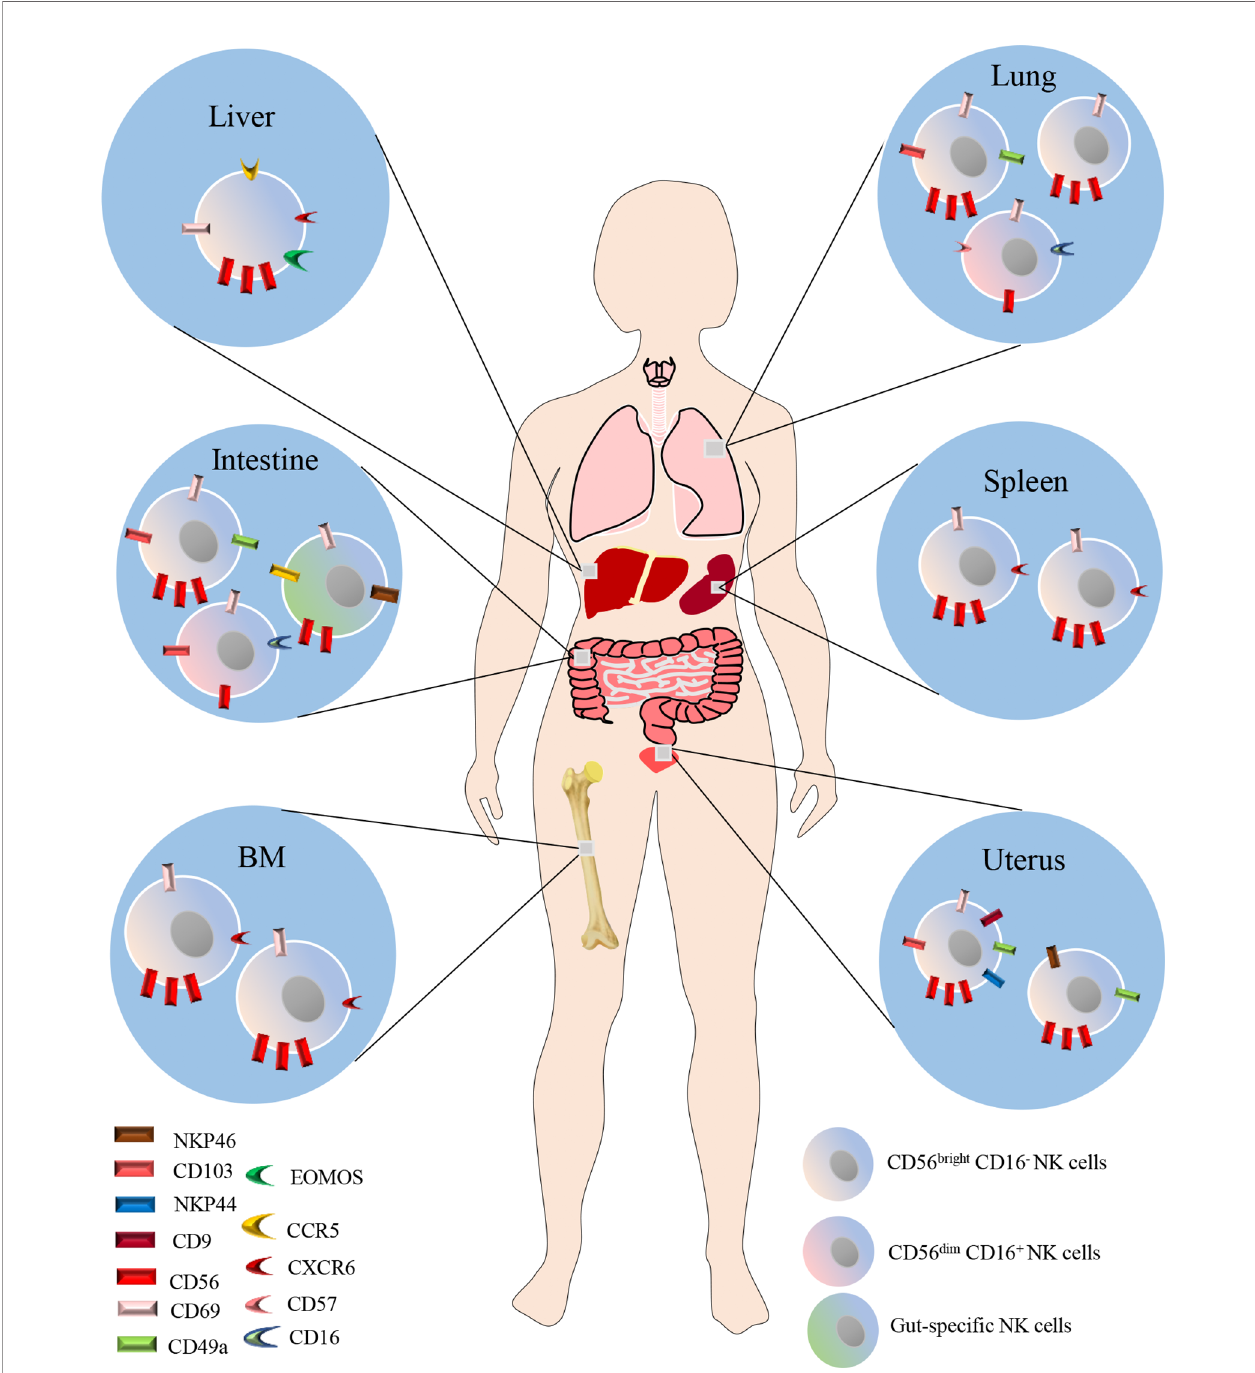
FIGURE 1 | NK cells also reside in peripheral tissues including liver, lung, spleen, BM, intestine and uterus under steady-state conditions. The majority of NK cells in the lung, BM, LNs and spleen are CD56 dim CD16 + , while CD56 bright CD16 - NK cells predominate in the liver, gut and uterus. CD56 bright CD69 + CXCR6 + NK cells de fi ne the BM and spleen resident NK cells. While CD56 dim CXCR6 + CD69 + NKP46 + NK cells de fi ne LN resident NK cells. In humans, NK cells constitute approximately 5-20% of the CD45-positive lung lymphocytes, and are located in lung parenchyma. Most lung NK cells show a mature CD56 dim CD16 + phenotype which takes a proportion of 80%, whereas CD56 bright CD16 − and CD56 dim CD16 − cells make up the remaining 20%, in equal ratios. A minority of the lung NK cells are tissue-resident, and could be speci fi cally de fi ned by CD49a + CD69 + CD103 + cells, which constitute 20% of lung NK